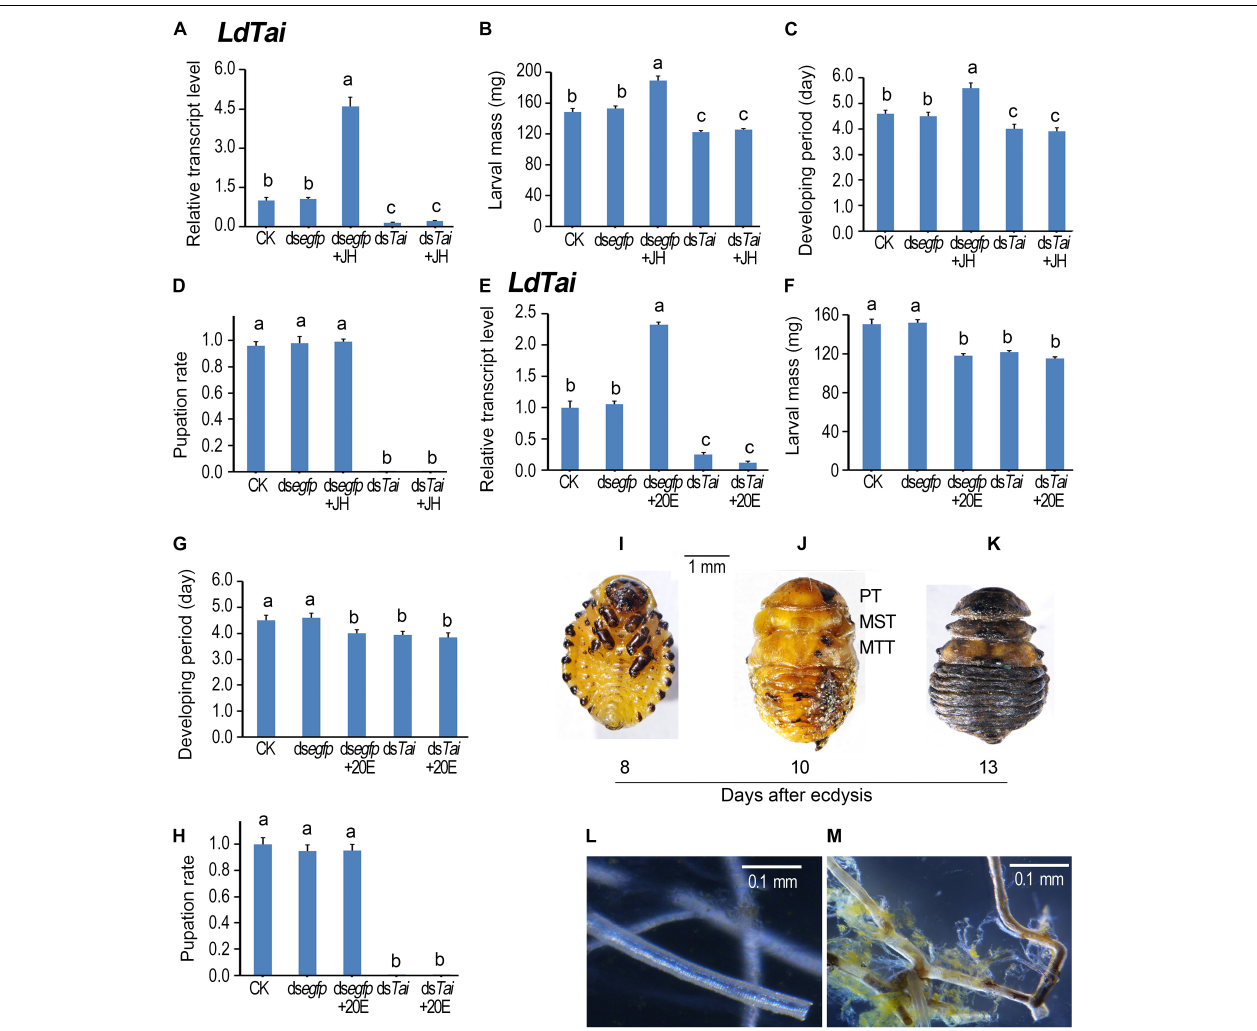
FIGURE 3 | Ingestion of ds Tai by the final instar larvae affects larval performance in Leptinotarsa decemlineata . The newly ecdysed final instar larvae had ingested PBS (CK)-, ds egfp -, JH-, ds Tai - and ds Tai +JH-dipped leaves, or PBS (CK)-, ds egfp -, 20E-, ds Tai - and ds Tai +20E-immersed foliage for 3 days, and untreated foliage for several days if necessary. The expression levels of LdTai (A,E) were tested. Relative transcripts are the ratios of relative copy numbers in treated individuals to PBS-fed controls (CK), which is set as 1. The larvae were weighed at an interval of 12 h after treatment to evaluate the maximum weight (B,F) . Developing periods were calculated from initiation of bioassay to occurrence of soil-digging behavior (C,G) . The pupation rates were recorded during a 4-week trial period (D,H) . The bars represent values ( ± SE). Different letters indicate significant difference at P -value < 0.05. The blank controls and ds egfp -exposed larvae became prepupae, pupae and adults 5, 7, and 12 days after experiment. Eight days after initiation of the experiment, these LdTai RNAi beetle were still wrapped in the old larval cuticles (I) . After removal of the apolysed larval cuticle, the LdTai RNAi prepupae possess pupal prothorax (PT), mesothorax (MST) and metathorax (MTT) (J) . Thirteen days after initiation of the experiment, the LdTai depleted prepupae are somewhat withered, dried and darkened (K) . The normal tracheae were formed after PBS- and ds egfp -fed beetles emerged to adults (L) . In contrast, the old tracheal linings still remained in tracheal trunks, some tracheae became brown in LdTai knockdown larvae (M)